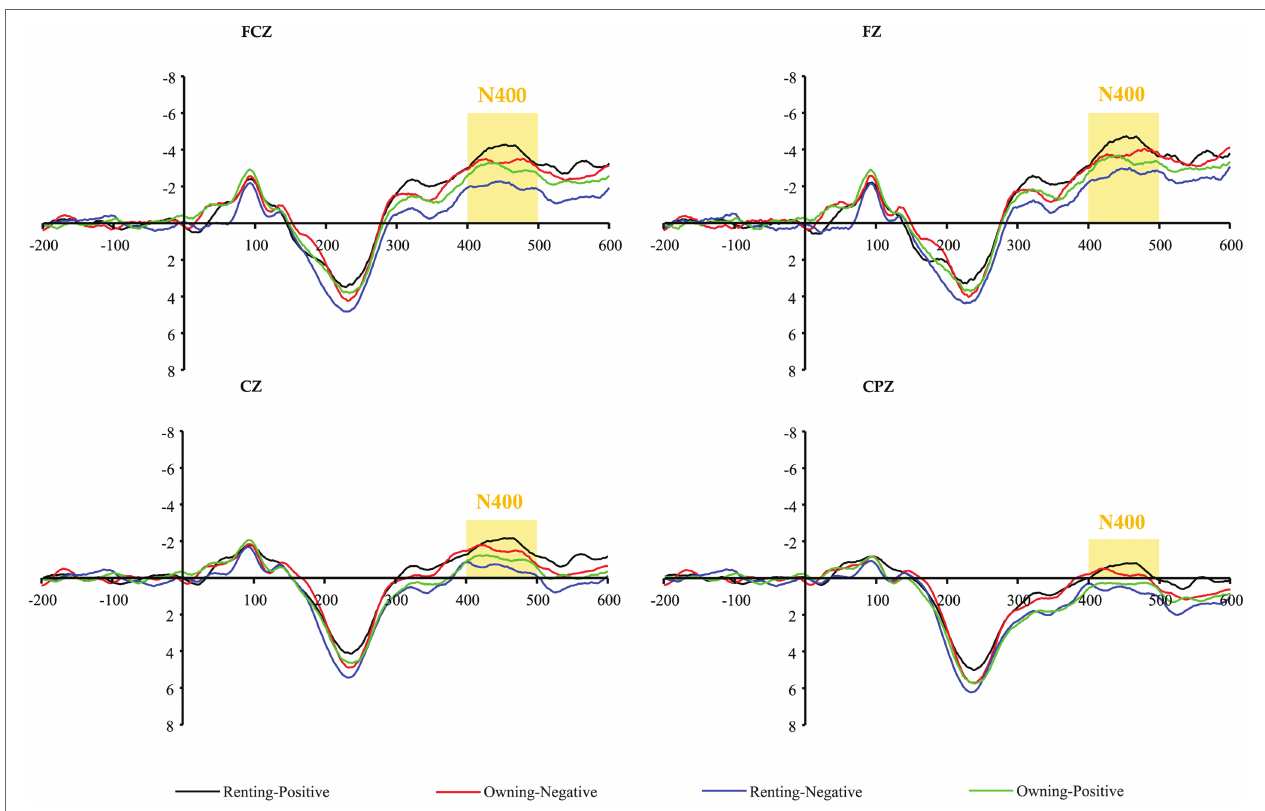
FIGURE 3 | Grand-average N400 event-related potentials (ERPs) waveforms evoked by adjectives in the four electrodes (Fz, FCz, Cz, and